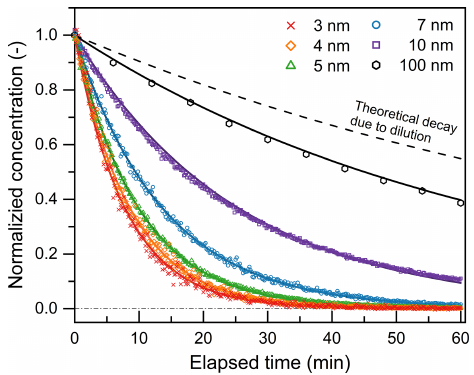
Figure 4. Decay of the concentration of NH 4 HSO 4 and NaCl par- ticles in the chamber due to wall loss and dilution. Particle concen- tration is normalized by dividing it by the value measured at t = 0. Curves are obtained by fitting Eq. (4) to the measured